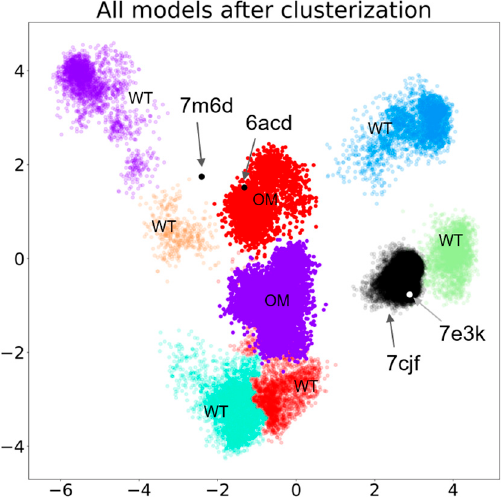
Figure 6. Clusterization results for omicron (bright, OM) superimposed on wild type (translucent, WT). Black translucent dots show the results of dPCA for molecular dynamics trajectory of the WT crystal structure 7cjf. Black and white bright dots show the location of crystal structures 6acd, 7e3k, and 7m6d on the map.